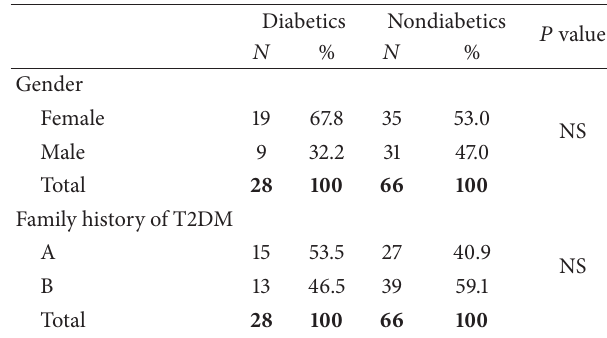
Table 1: Relation according to the range of fasting glucose levels (FGL).